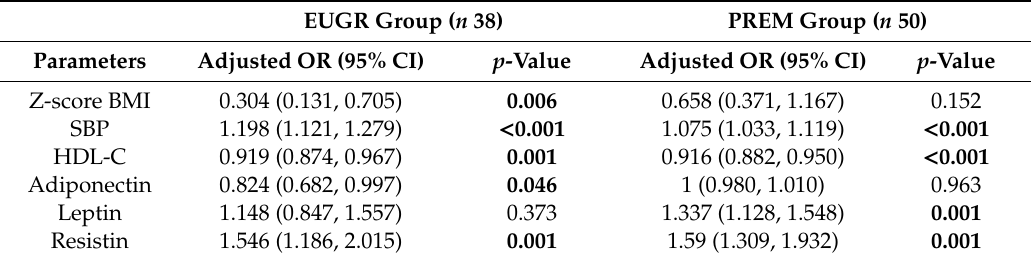
Table 5. Results of multiple logistic regression analysis to identify variables in prepubertal children associated with the condition of prematurity without extrauterine growth restriction (PREM group) and prematurity with extrauterine growth restriction (EUGR